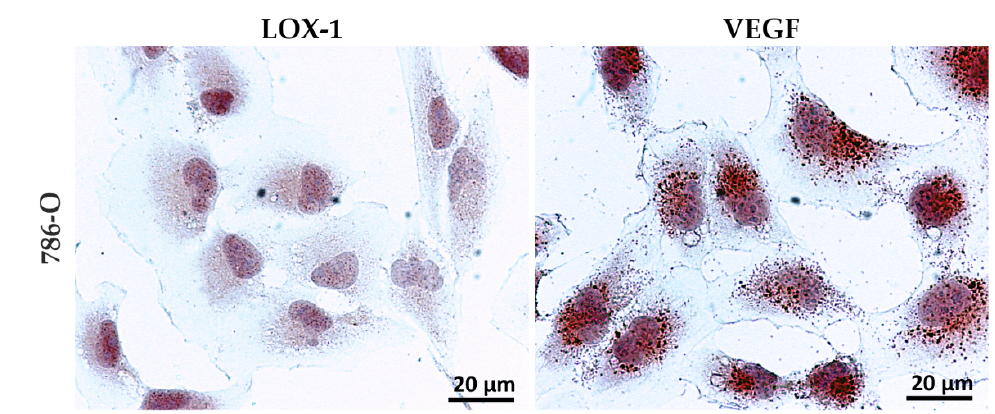
Figure 1. Immunocytochemistry analyses in 786-O cells. LOX-1 ( left ) and VEGF-A ( right ) immuno- cytochemistry analyses in 786-O ccRCC cell line. Scale bar 20 μm.